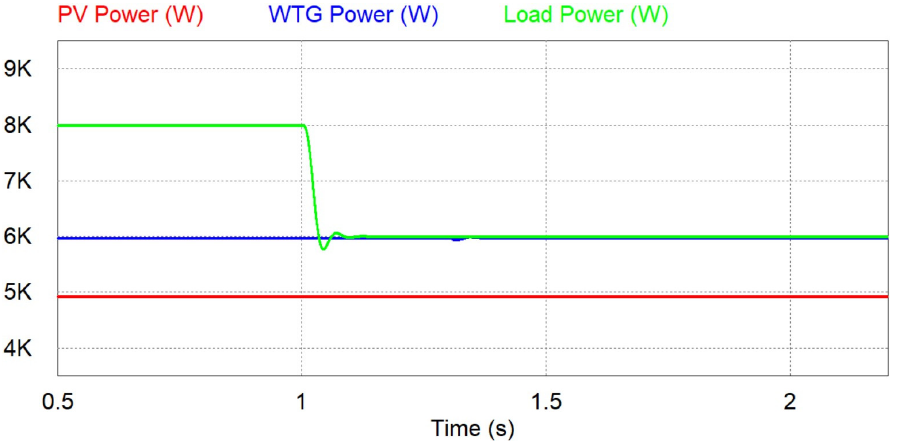
Figure 13. The power of PV, WTG, and load—Case 2.